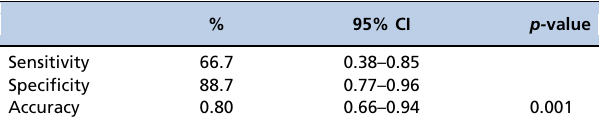
Table 2 - Diagnostic performance of the Timed Up and Go test for predicting sarcopenia in the sample of 68 elderly hospitalized